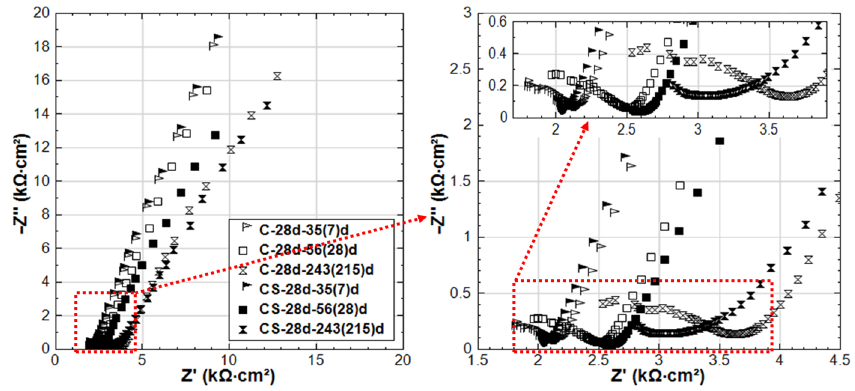
Figure 12. EIS responses overlay in Nyquist format of C-28d and CS-28d (C-28d: NaCl medium, CS-28d: NaCl + Stray Current, 28d-cured specimens treated in 5% NaCl).